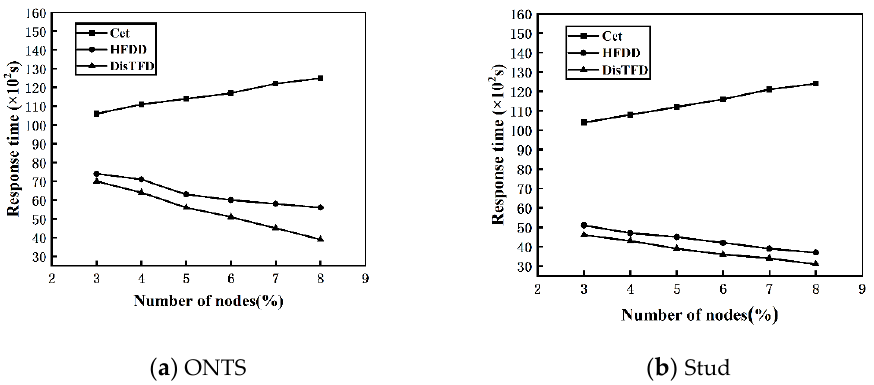
Figure 7. ( a ) Response time with different number of nodes (ONTS) ( b ) Response time with different number of nodes (Stud).